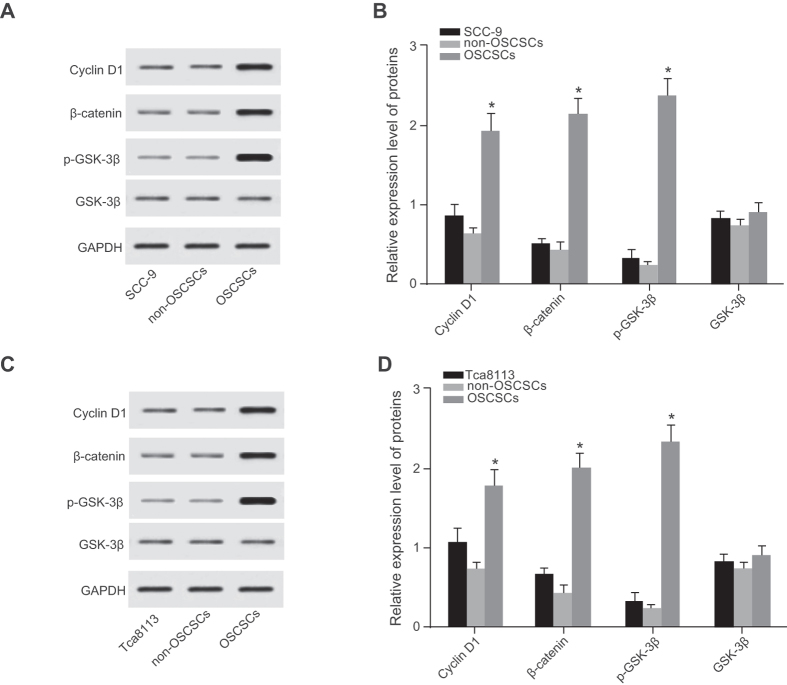
The expression of the proteins of the Wnt/β-catenin signaling pathway in OSCSCs.(A,B), The expression of the proteins of the Wnt/β-catenin signaling pathway in SCC-9 cells, non-OSCSCs and SCC-9 OSCSCs detected by Western blotting. *Represents P < 0.05 comparisons with SCC-9 cells and non-OSCSCs. C and D, The expression of the proteins of the Wnt/β-catenin signaling pathway in Tca8113 cells, non-OSCSCs and Tca8113 OSCSCs. *Represents P < 0.05 compared with Tca8113 cells and non-OSCSCs. OSCSCs, oral squamous carcinoma stem cells.